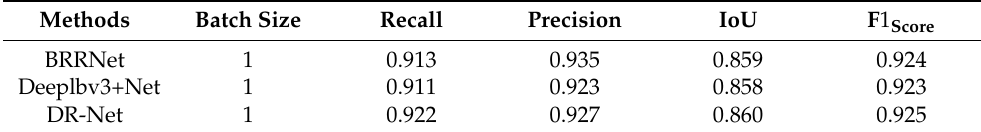
Table 2. The performance of different methods.